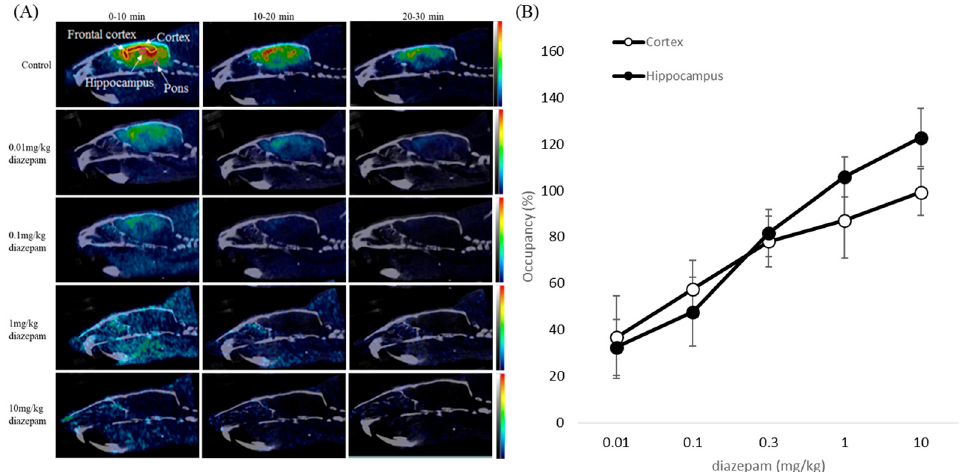
Figure 7. The PET images for dose-dependent inhibition of [ 18 F]flumazenil by pre-treatment with diazepam (0.01, 0.1, 1, 10 mg/kg). ( A ) The specific uptake in frontal cortex, cortex, and hippocampus as showed by NanoPET/CT image. ( B ) When pre-treating rats with diazepam, the images were significantly diminished. Increasing the dose of diazepam resulted in reduced cerebral uptake of [ 18 F]flumazenil. Maximal displacement was achieved within a period of 10 min post-injection of [ 18 F]flumazenil.